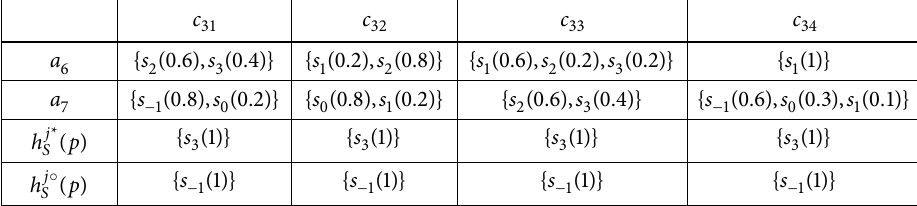
Table 3. The evaluation information of innovation and entrepreneurship talents